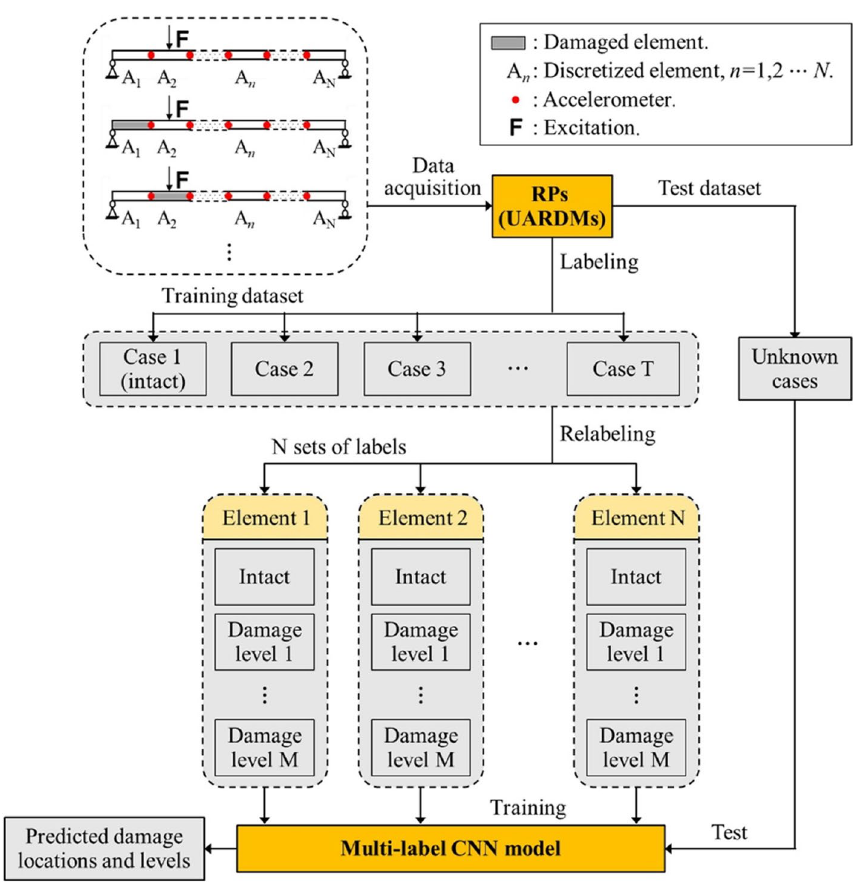
Fig. 4 Flowchart of structural damage identification using the multi‑label CNN model Li et al